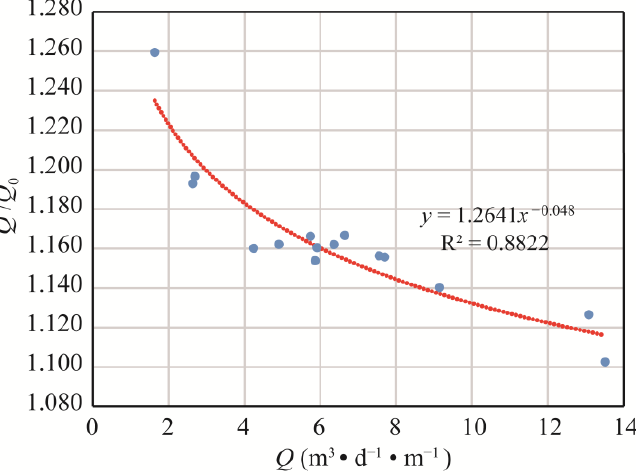
Figure 9. Variation in / Q Q values with the magnitude of water inflow Q . 0 0